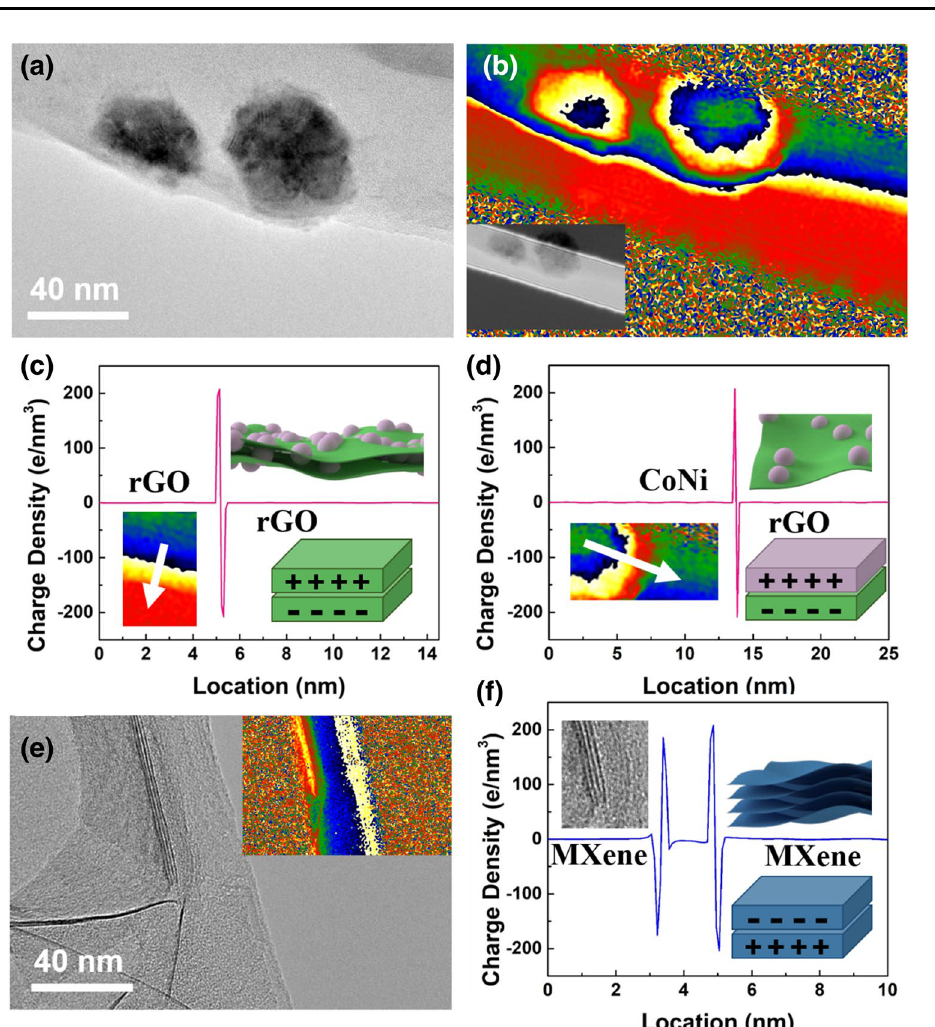
Fig. 8 a TEM image, b charge density images and c , d charge density profiles in the region of the white arrow of rGO/CoNi; e TEM image and f charge density profiles in the region of the white arrow of